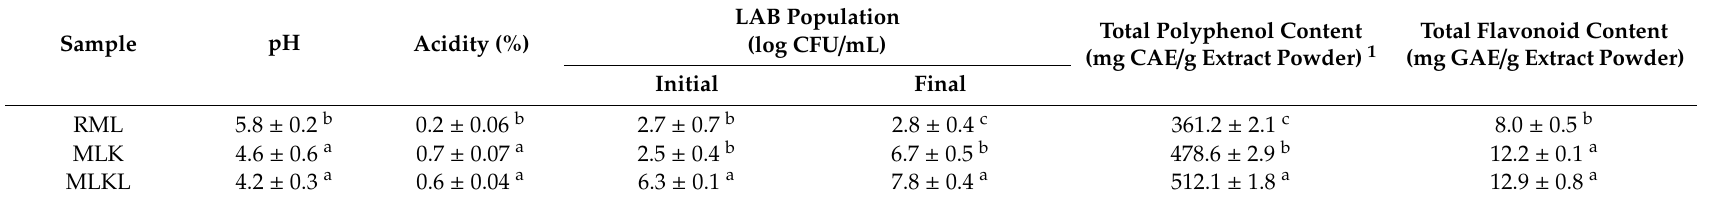
Table 1. Total polyphenol and flavonoid contents of mustard leaf kimchi